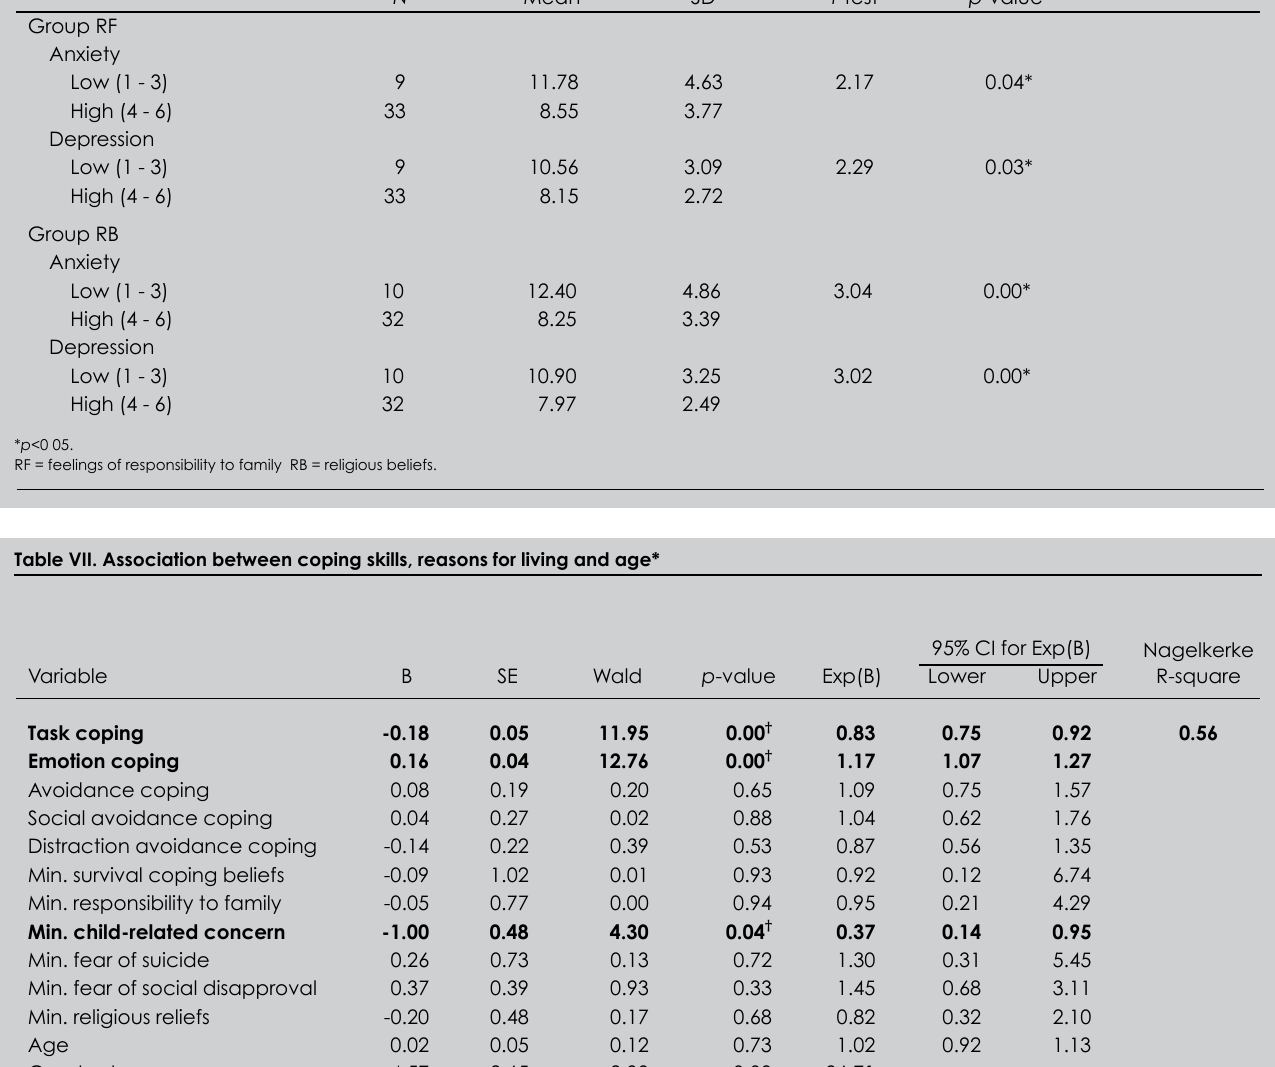
N Mean SD t -test p -value